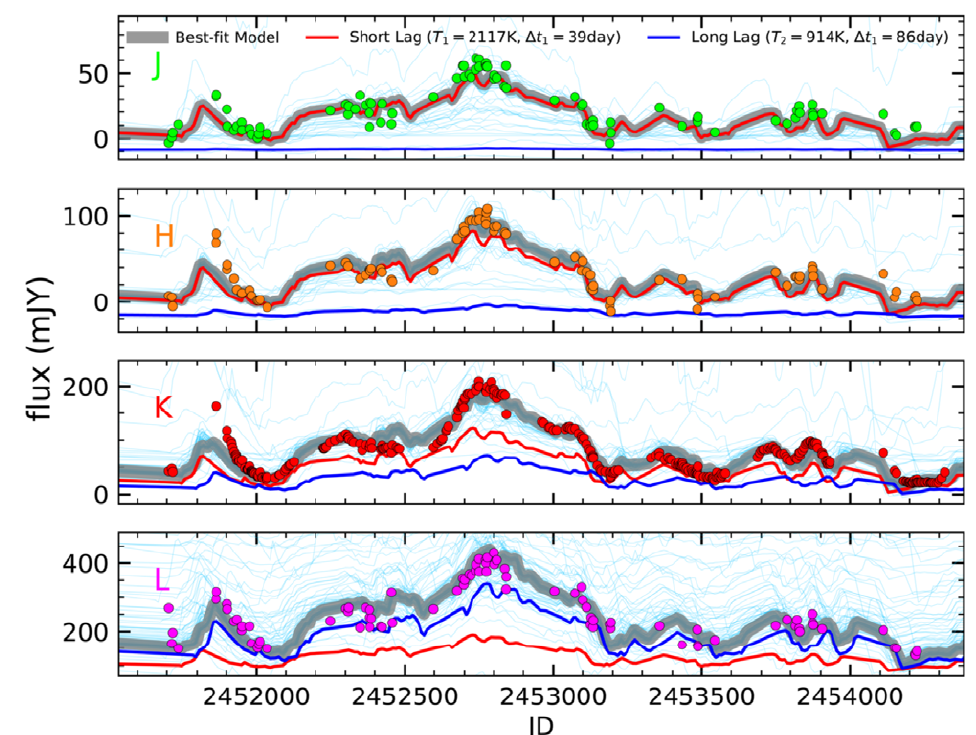
Figure 15. All the near-IR light curves for NGC 4151 in the best-sampled interval, fitted with an integrated two-black-body dust reverberation model. The observed light curves are shown as dots with different colors. The best-fit model is shown as a thick grey line and the contribution from the two different dust components as red and blue lines. The relative contribution of the long lag (blue line) gradually increases towards the longer wavelength and finally dominates the L-band